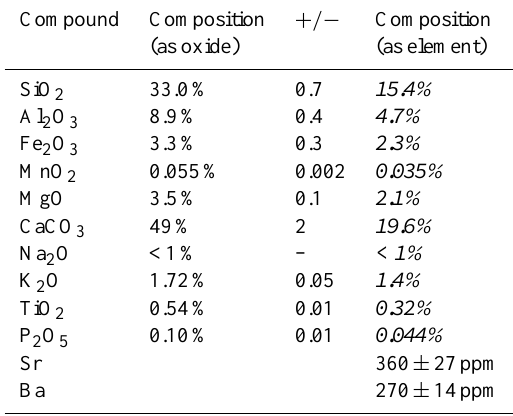
Table 1. Elemental composition of the soil for the major and minor elements. Sr and Ba are from Desboeufs et al. 2014, Q sample for Sr, R for Ba). The right column, written in italics, is the elemental composition.